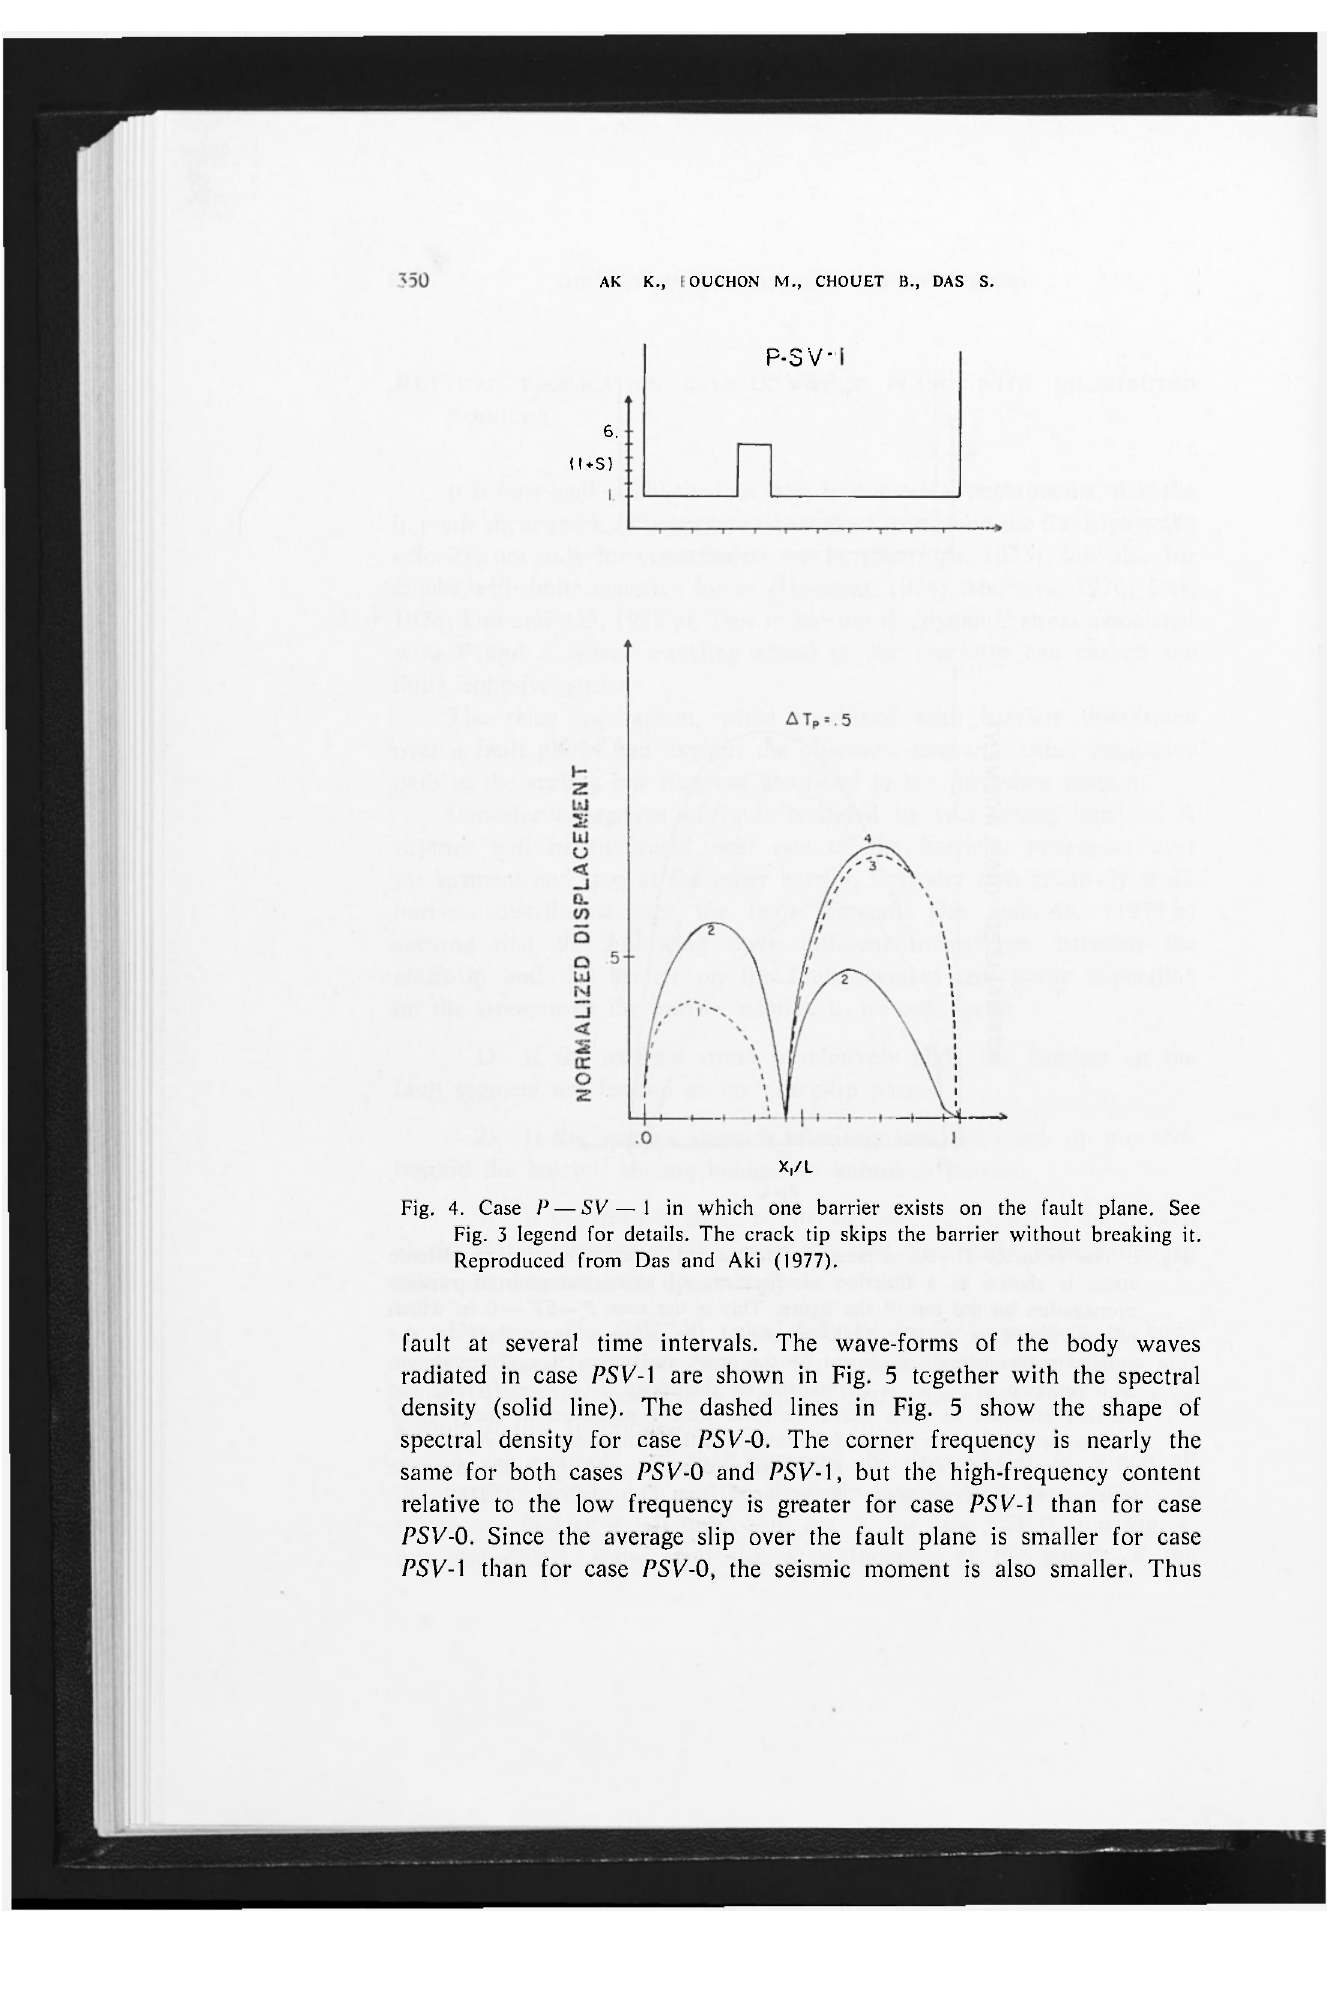
Fig. 4. Case P — SV —1 in which one barrier exists on the fault plane. See Fig. 3 legend for details. The crack tip skips the barrier without breaking it. Reproduced from Das and Aki